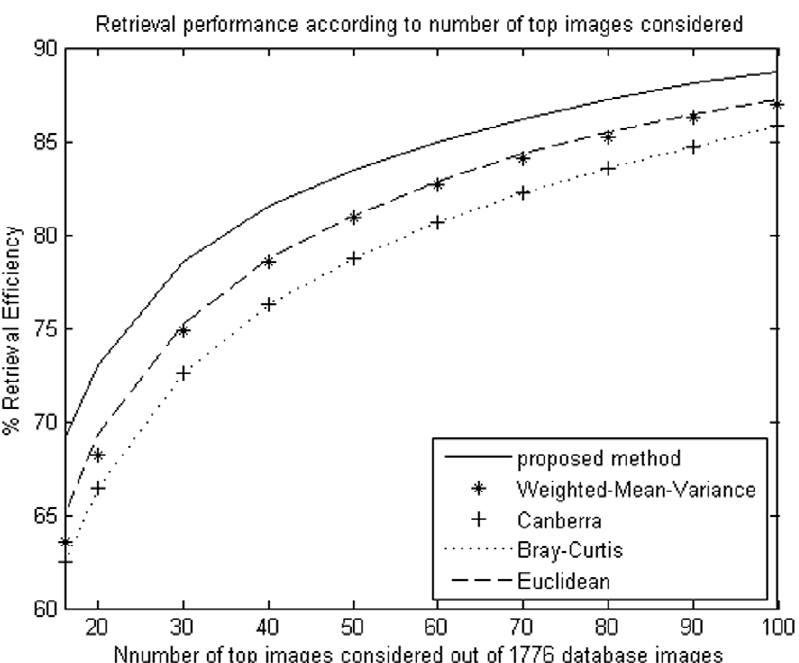
Figure 7. Average retrieval rate of database according to the number of top retrieved images using NSCT. The Brodatz image database (1776 images) were used.